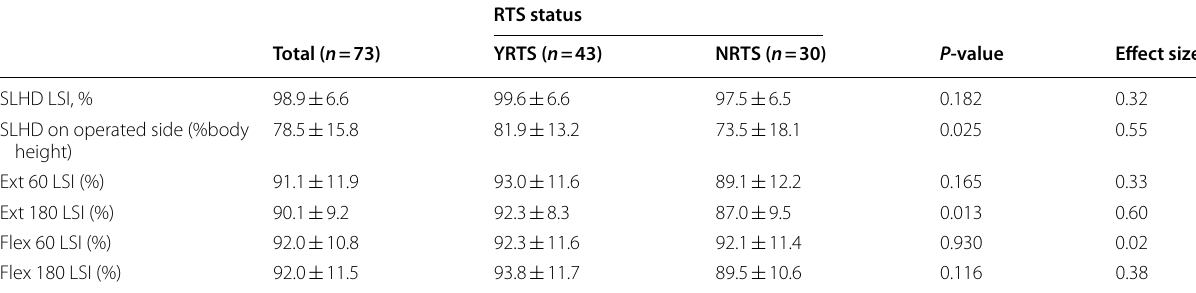
92.0 10.8 ± ACLR anterior cruciate ligament reconstruction, RTS return-to-sports, YRTS yes ‒ return-to-sports, NRTS no ‒ return-to-sports, SLHD single-leg hop distance, LSI limb symmetry index Ext and Flex 60/180 represent the isokinetic knee extension and flexion torque at 60°/s or 180°/s